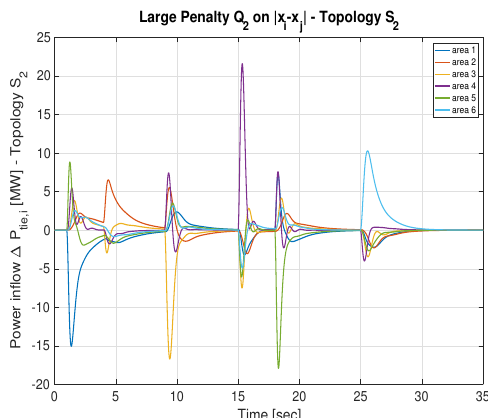
Figure 16. Total power inflow deviation ∆ P tie , i response for i = 1, · · · ,6, topology S 2 , control tuning with Q 2 = 200 Q 1 , uncertain parameters.